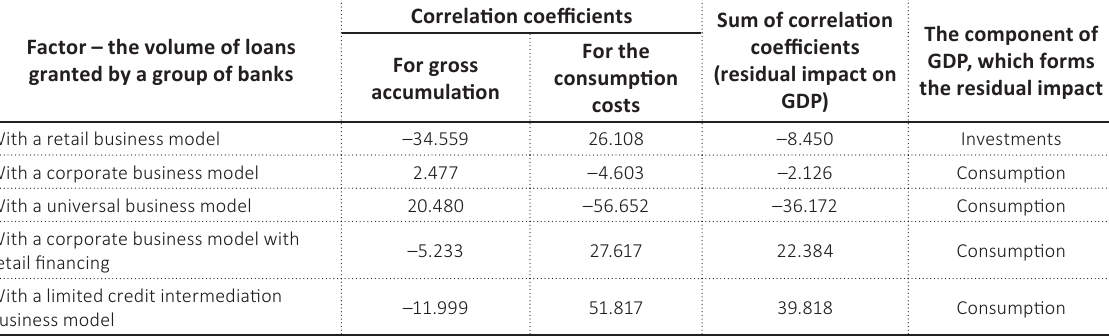
Table 4. Assessing the residual impact of changes in business architecture of the Ukrainian banking sector on